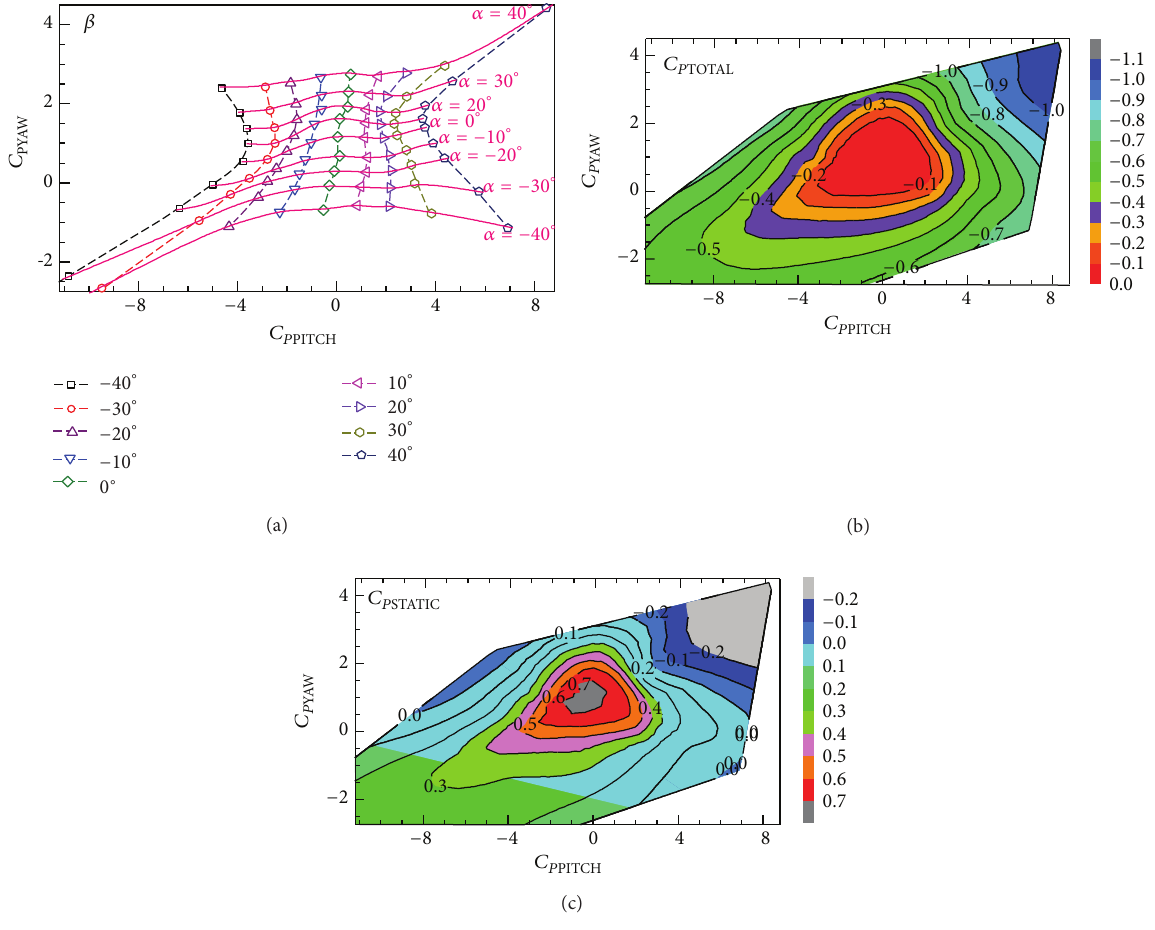
Figure 5: Calibration curves of miniature four-hole